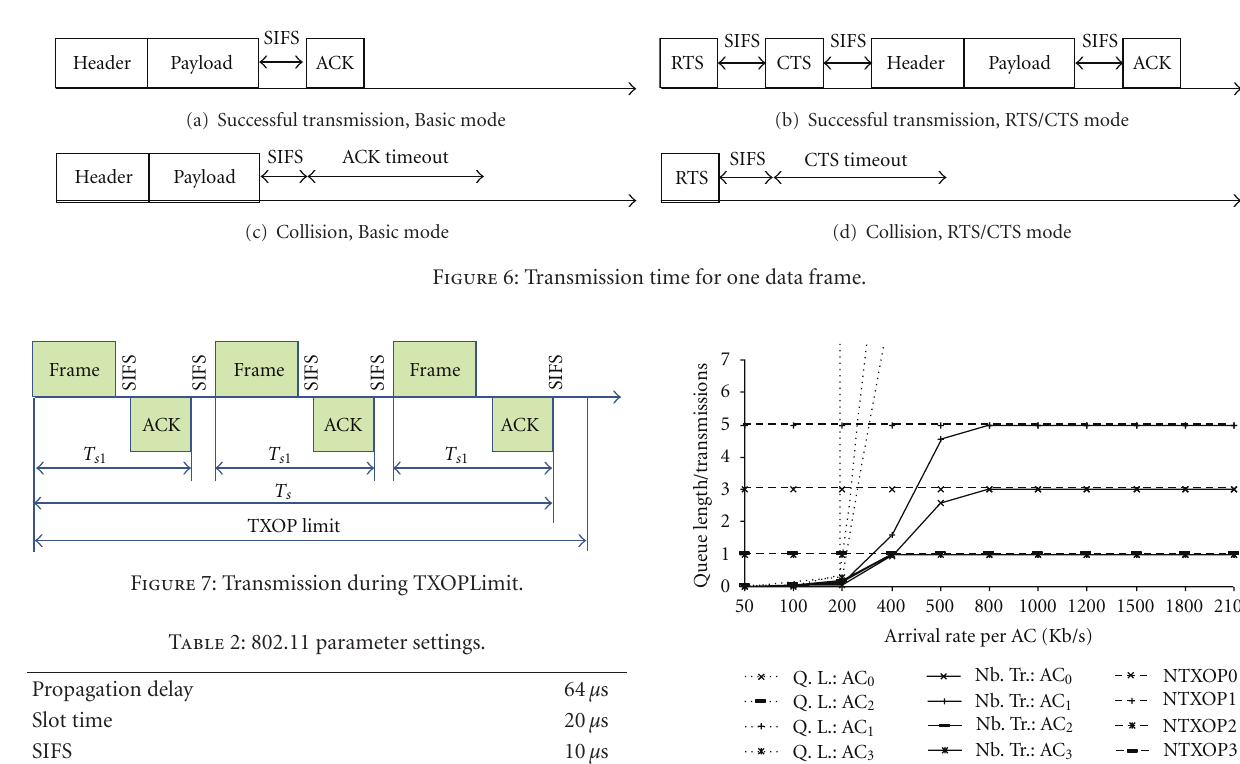
Figure 8: Average queue length versus average number of transmis- sions, for di ff erent load rates and for all ACs.